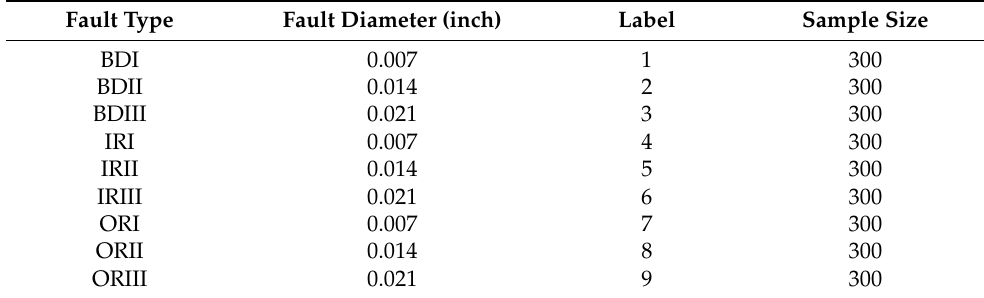
Table 1. Data information on nine types of fault